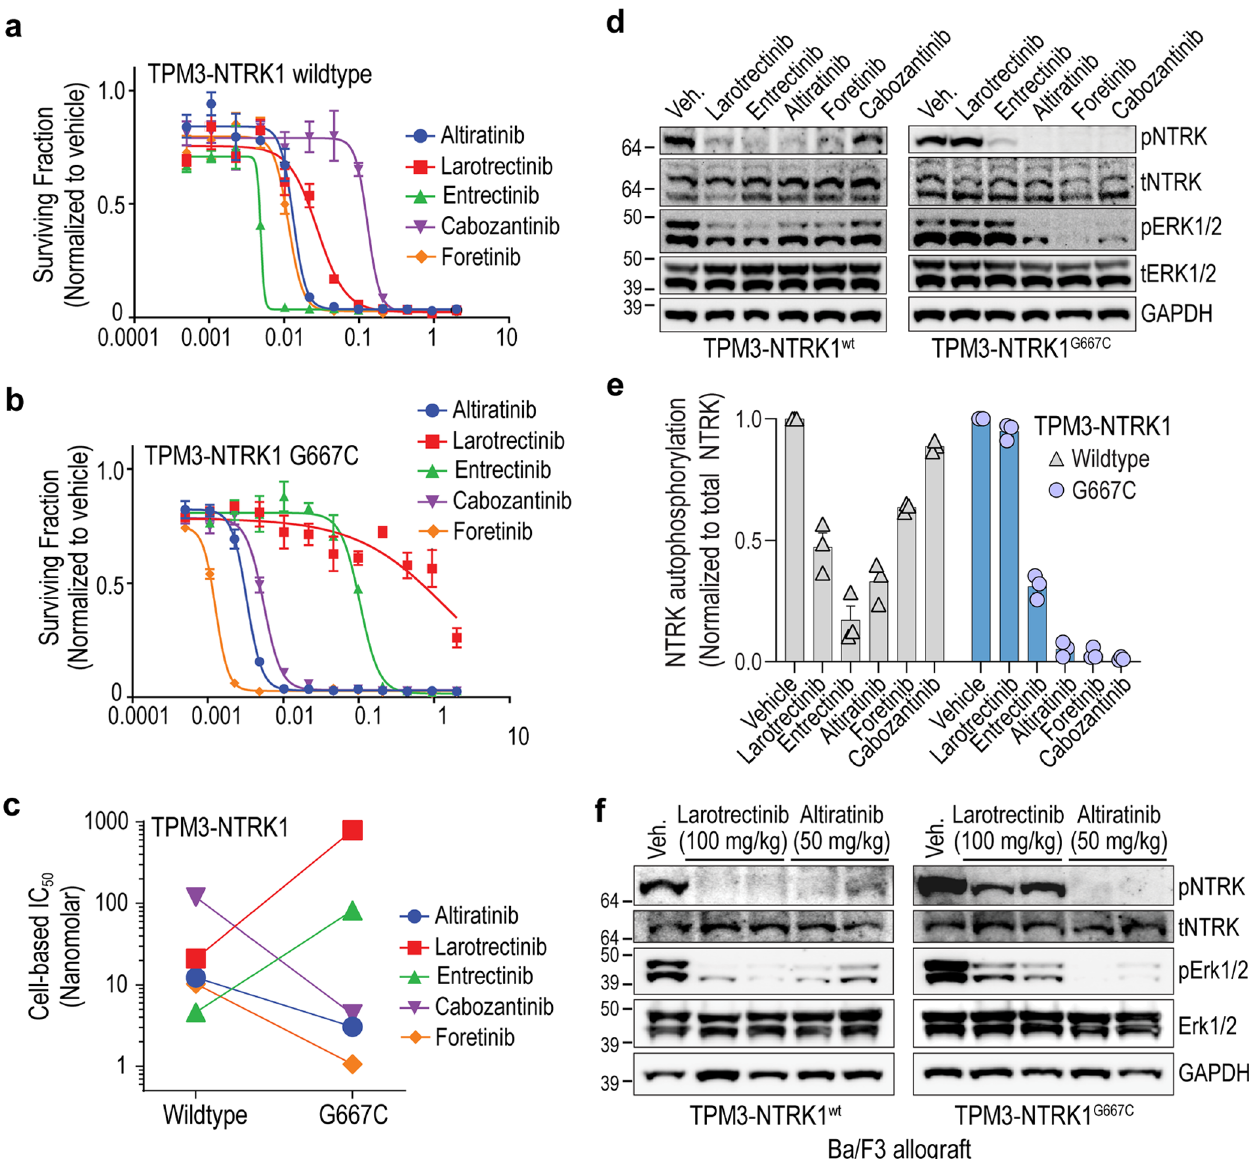
Fig. 5 The xDFG mutation NTRK1 G667C sensitizes the kinase to type II inhibitors. Dose response cell viability data comparing the activity of indicated inhibitors in Ba/F3 TPM3-NTRK1 ( a ) or TPM3-NTRK1 G667C ( b ) cell lines after 72 h treatment. Data are representative of four independent experiments for larotrectinib, entrectinib, and altiratinib, and three independent experiments for cabozantinib and foretinib. Average ± SEM from three replicates shown. c Scatter plot compares IC 50 of indicated inhibitor for Ba/F3 TPM3-NTRK1 wildtype versus G667C mutant cells. d Immunoblot analysis of TPM3-NTRK1 wt (wildtype) TPM3-NTRK1 G667C autophosphorylation (pNTRK) and effector protein, Erk1/2 phosphorylation (pErk1/2) and corresponding total NTRK (tNTRK) and total Erk1/2 (tErk1/2) as well as loading control (Gapdh) levels from Ba/F3 cells treated with indicated inhibitors. “ Veh. ” indicates vehicle (DMSO) treatment. Data are representative of three independent experiments. e Densitometry of pixel intensity to show relative auto-phosphorylation of TPM3-NTRK1 wildtype (red columns) and G667C (blue columns) mutant from three experiments. Average ± SEM are shown. Individual values are shown as symbols at the top of the column: wildtype — triangles and G667C — circles. f Immunoblot analysis from Ba/F3 allograft tumors with lysates harvested 3 h after a single dose of larotrectinib (100 mg/kg) or altiratinib (50 mg/kg) treatment. TPM3-NTRK1 wt (wildtype) TPM3-NTRK1 G667C autophosphorylation (pNTRK) and effector protein, Erk1/2 phosphorylation (pERK1/2) and corresponding total NTRK (tNTRK) and total Erk1/2 (tErk1/2) as well as Gapdh (loading